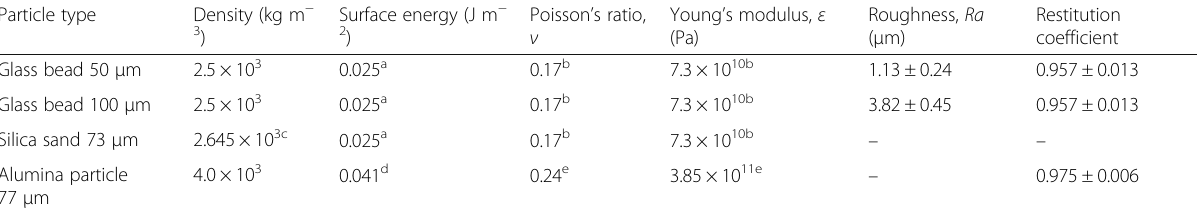
Table 1 Physical characteristics of particles